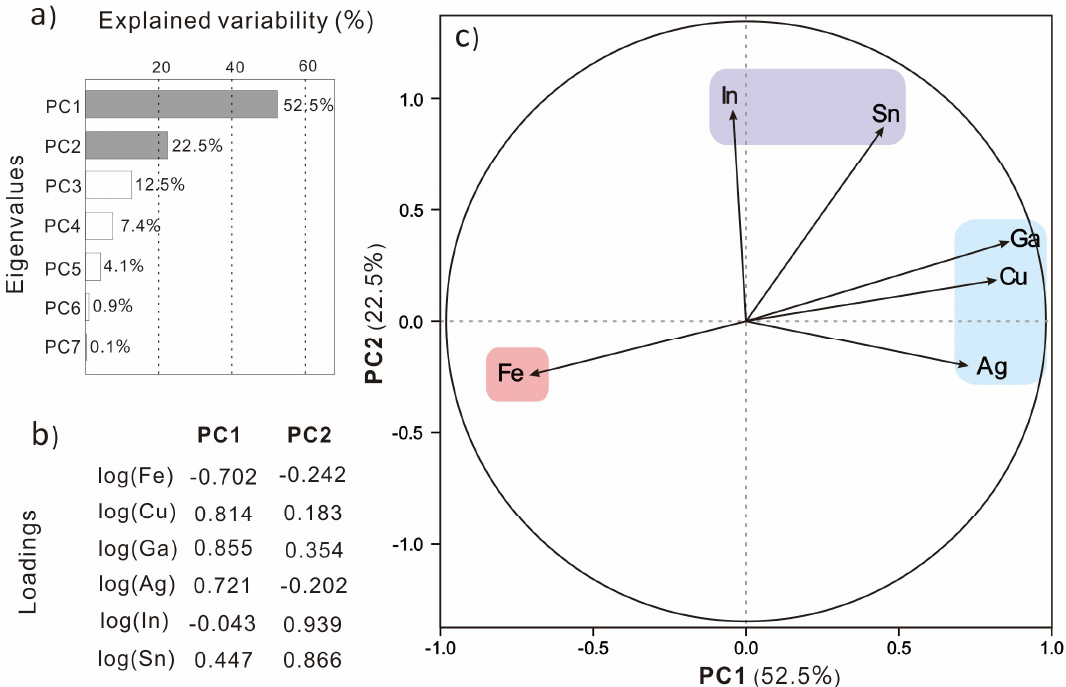
Figure 8. Principal components analysis of the trace element contents (log-transformed) in sphalerite from the Nayongzhi deposit. On the left-hand side edge: eigenvalues ( a ) (i.e., explained variability) and loadings ( b ) (i.e., eigenvector coefficients) of the principal components. Right frame ( c ) elements (i.e., variables) plotted on the PC1 vs. PC2. plane (explaining 75% of the total variability), cluster of elements showing similar behavior are marked as Fe, (In, Sn) and (Ga, Cu, Ag). The angle between two arrows in ( c ) is related to the covariance between the concentrations of the corresponding elements: if the angle is close to 0 ◦ , then the elements are positively correlated, if the angle is close to 90 ◦ , then they are not correlated, and if it is close to 180 ◦ , then they are negatively correlated.